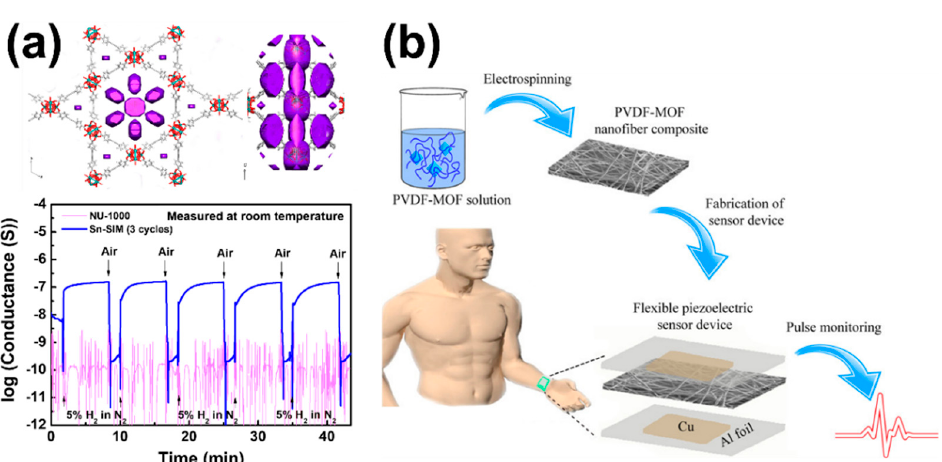
Figure 10. ( a ) (top) Electron density map of 1D tin oxide strands (shown in purple color) deposited within the hexagonal mesoporous channels of NU-1000; (bottom) chemiresistive hydrogen sensor operated at room temperature with the use of the Sn-SIM (3 cycles) material. Adapted with permission from [208] . Copyright (2018) American Chemical Society. ( b ) The addition of Zr-MOF (UiO-66) into PVDF membrane to enhance the piezoelectric sensing performance for arterial pulse monitoring. Reprinted with permission from [212] . Copyright (2020) American Chemical Society.